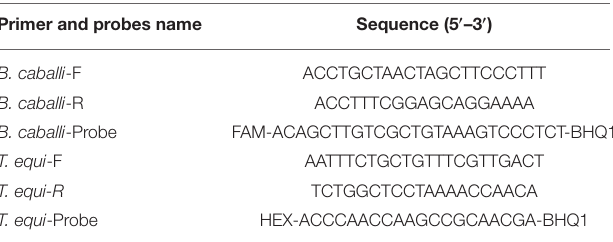
TABLE 3 | Sequence of primers and probes of duplex real-time fluorescence quantitative PCR for detecting T. equi and B. caballi